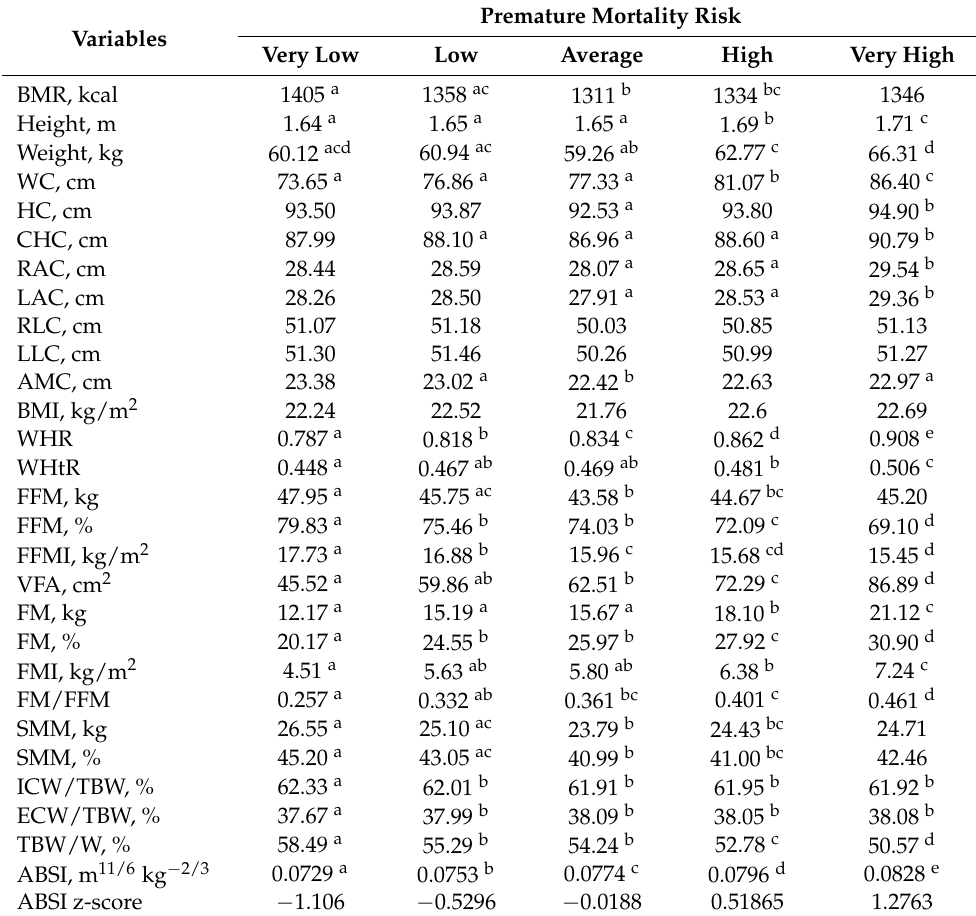
Table 4. Relationship between ABSI z-score with anthropometric